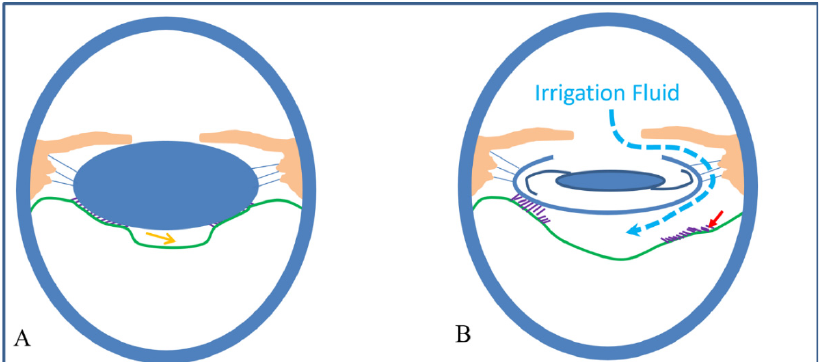
Figure 6. Schematic diagram of Wieger zonular damage and increasing width of Berger’s space during phacoemulsification. ( A ) The yellow arrow indicates Berger’s space with natural lens before surgery (the green line indicated as the anterior hyaloid of the vitreous; the purple lines indicated the Wieger zonular). ( B ) The curved dash line indicates extensive irrigation fluid through the zon ‐ ular network, resulting in partial Wieger zonular damage (red arrow).